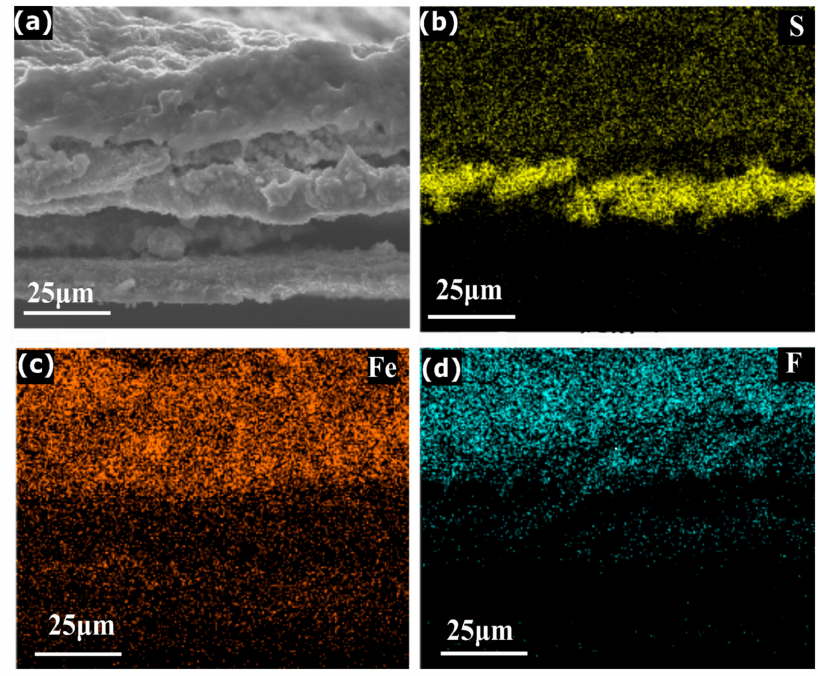
Figure 4. SEM and EDS mapping analysis of a cross-section of the FePS 3 electrode discharged till 0.5 V: ( a ) secondary electron image of SEM and ( b ) S (yellow), ( c ) Fe (orange) and ( d ) F (blue) elemental mapping using